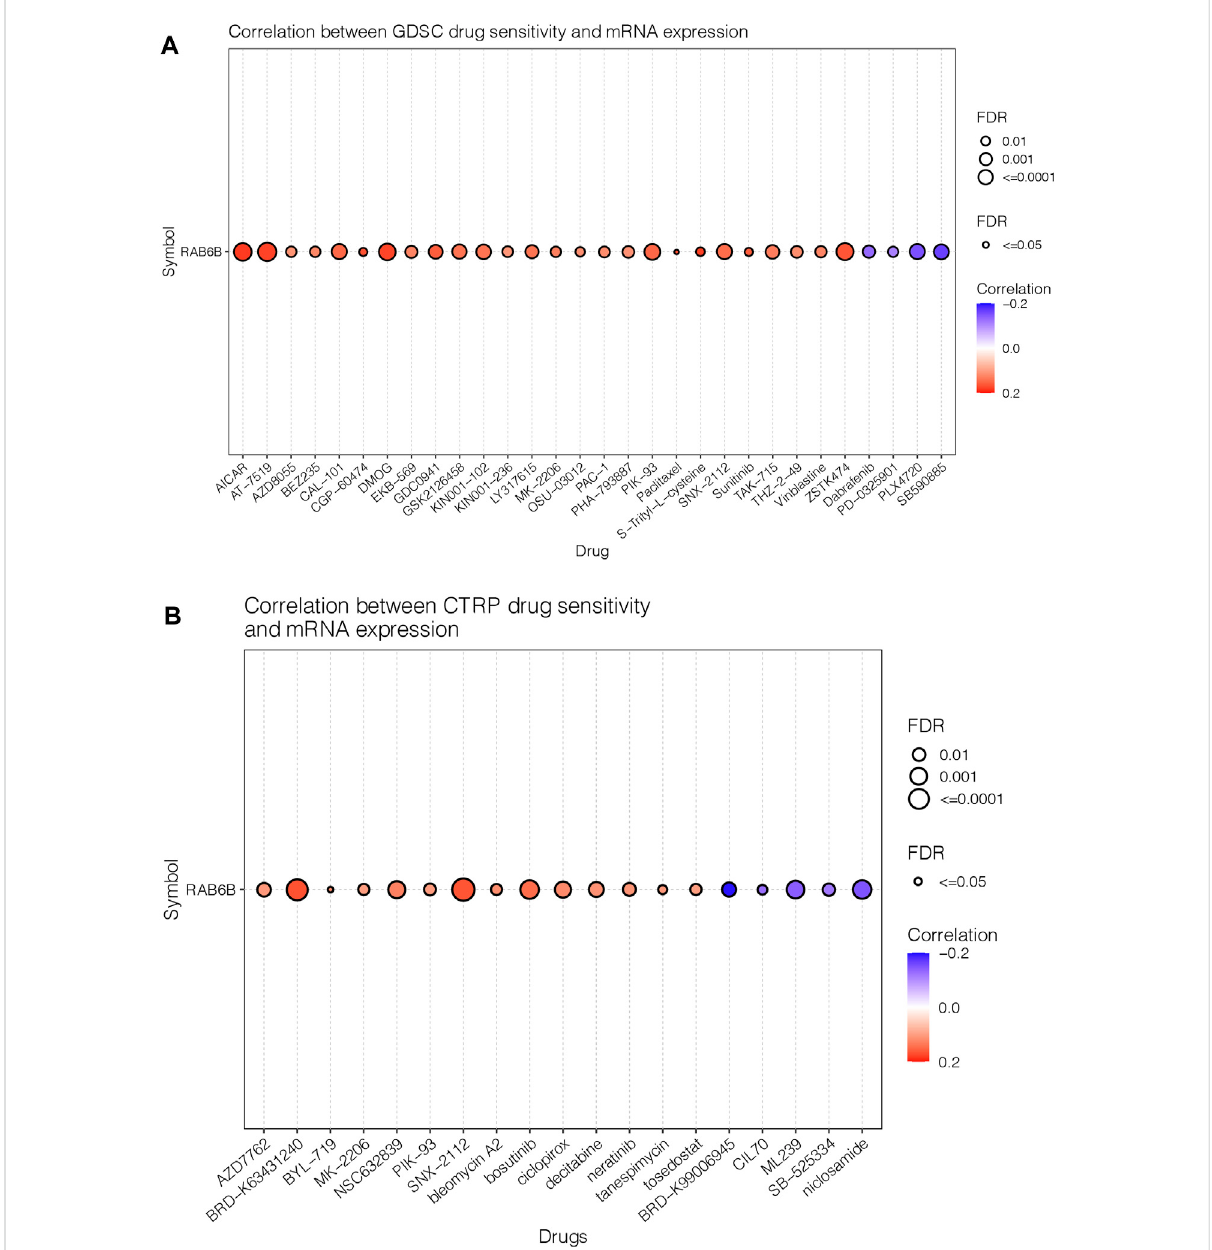
FIGURE 8 CorrelationbetweenRAB6Bexpressionanddrugresponse. (A) DotplotsummarizedtherelationshipbetweenRAB6BmRNAexpressionandthe sensitivity of GDSC drugs (top 30) in pan-cancer. GDSC, Genomics of Drug Sensitivity in Cancer. (B) RAB6B mRNA expression and the sensitivity of CTRP drugs (top 30) in pan-cancer. CTRP, Cancer therapeutics Response